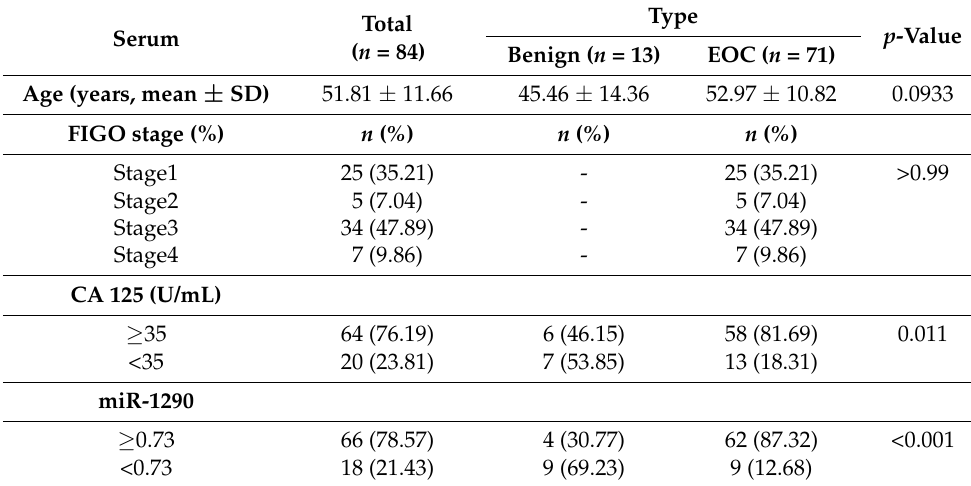
Table 2. Characteristics of the serum sample from